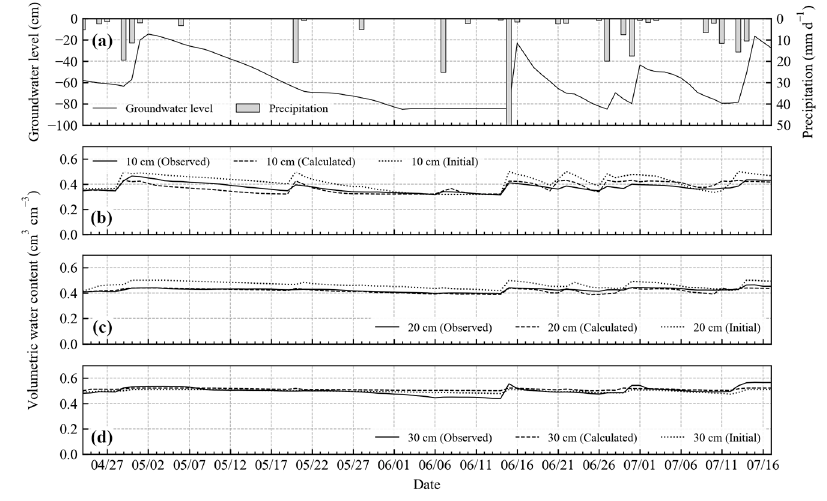
Figure 4. Volumetric water content in the calibration plot in 2019. ( a ) Groundwater level and precipitation; ( b – d ) results at depths of 10, 20, and 30 cm, respectively. The maximum daily precipitation, 51.7 mm d − 1 , occurred on 15 June 2019. The results with initial and calibrated soil hydraulic parameters were generated using the data in Tables 4 and 5, respectively.